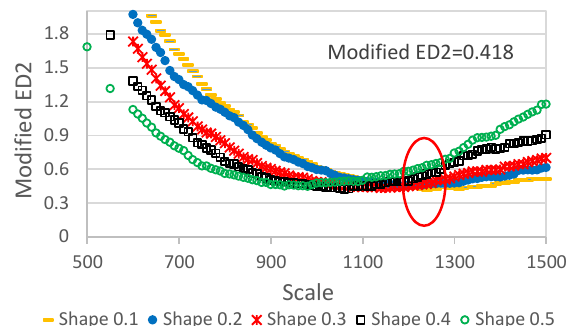
Figure 4 . Modified ED2 computed by using AssesSeg for MRS outputs from Deimos-2 PANSH orthoimage.